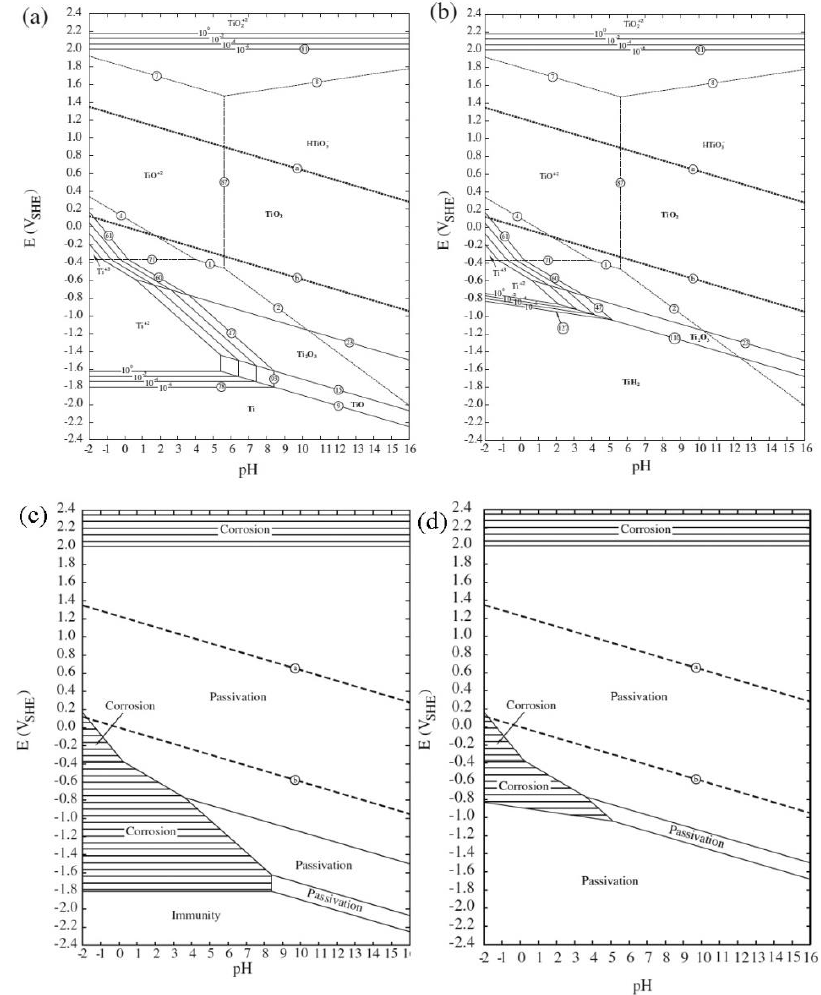
Figure 12. Pourbaix diagram of the Ti–H 2 O system at 25 ◦ C: ( a ) not taking into account titanium hydrides and ( b ) taking into account titanium hydrides. Line numbers correspond to reaction numbers in Ref. [186]. Solid lines bound the stability regions of the solid phases in equilibrium with 10 –6 , 10 –4 , 10 –2 and 100 M activity values of the soluble titanium species. Fine broken lines mark equilibria between the dissolved species. ( c ) and ( d ) are the corresponding Pourbaix diagrams for (a) and (b), respectively, when marking only the immunity, passivation and corrosion domains [186]. Reprinted with permission of